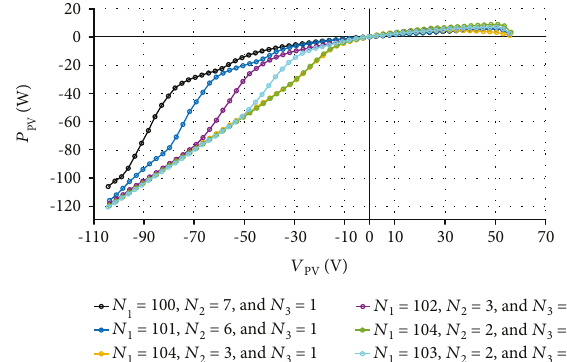
Figure 20: Full version (for both positive and negative voltages) of the P - V characteristics of the three series-connected PVUs with di ff erent numbers of shaded cells. 27 September 2017, Aversa Figure 18: Full version (for both positive and negative voltages) of (CE), Italy. S 1 = 841 W/m 2 , S 2 = 198 W/m 2 , and S 3 = 330 W/m 2 ; the P - V characteristics of the three series-connected PVUs with a growing number of shaded cells. 27 September 2017, Aversa (CE), Italy. S 1 = 775W/m 2 characterizes the unshaded cells, and S 2 = 180 = 26 ° C . W/m 2 characterizes the shaded cells; T amb